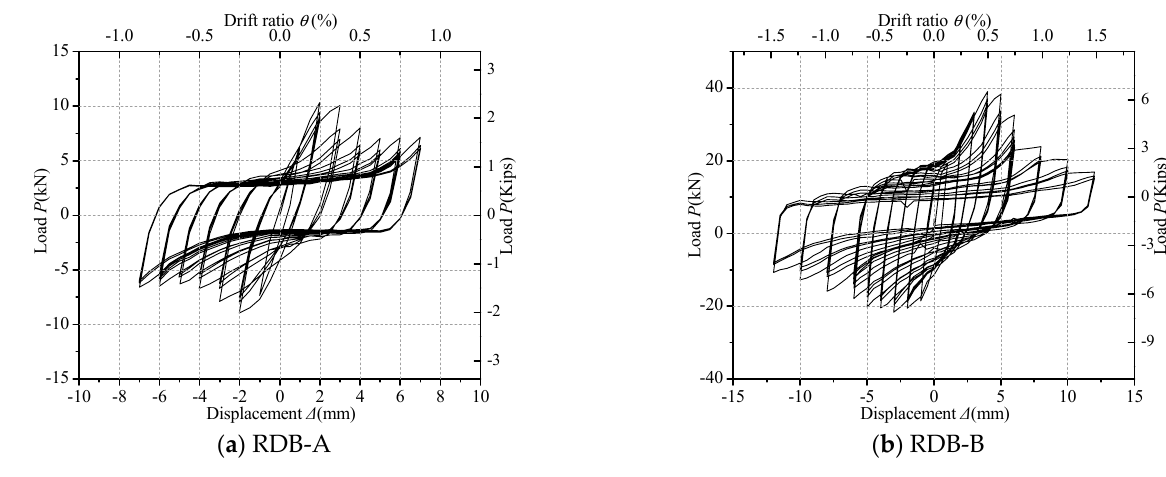
Figure 7. Loading-displacement curves of the specimens.